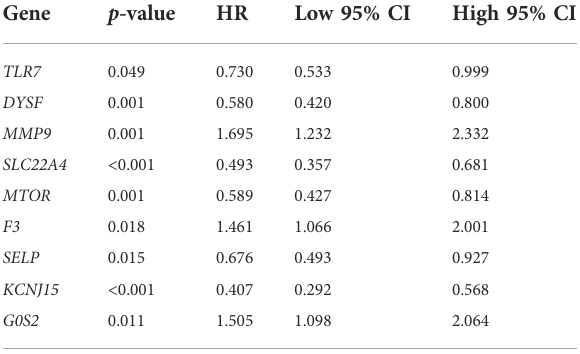
TABLE 2 NET-related genes with signi fi cant prognosis in progression- free survival analysis. Gene p- value